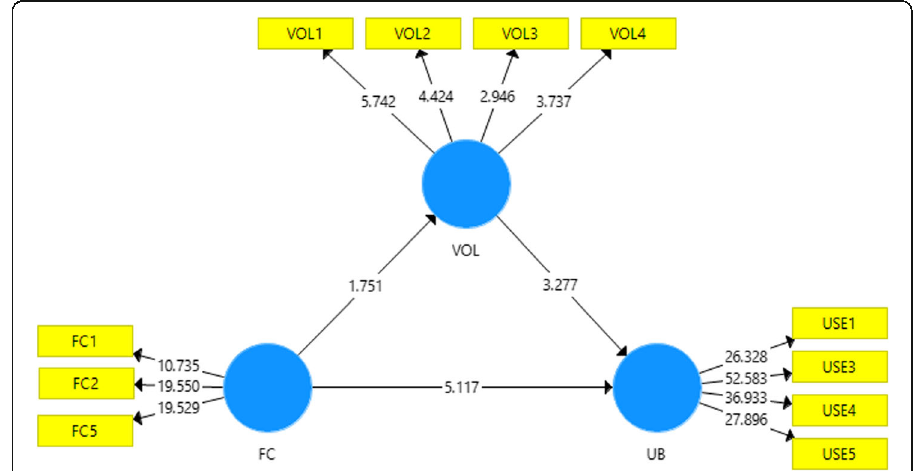
Fig. 3 Bootstrap results for path